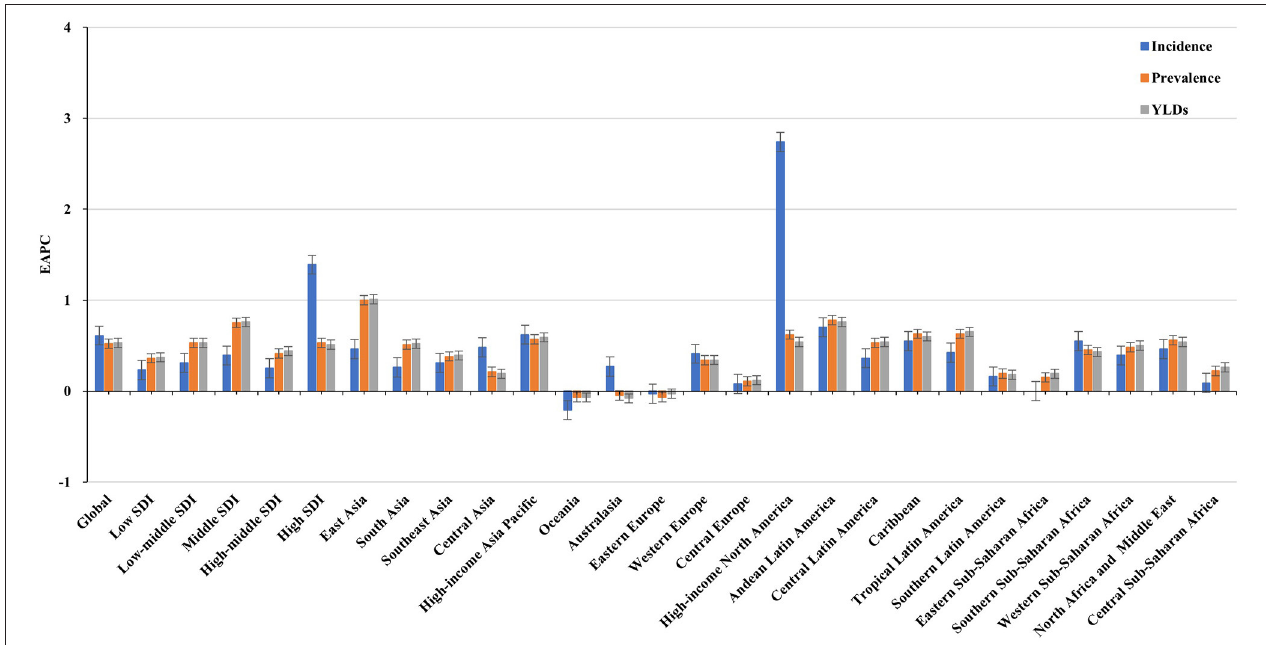
FIGURE 1 | Trends in the ASR of incidence, prevalence, and YLDs of Parkinson’s disease in global, SDI areas and geographic regions from 1990 to 2019. ASR, age-standardized rate; SDI, sociodemographic index; YLDs, years lived with